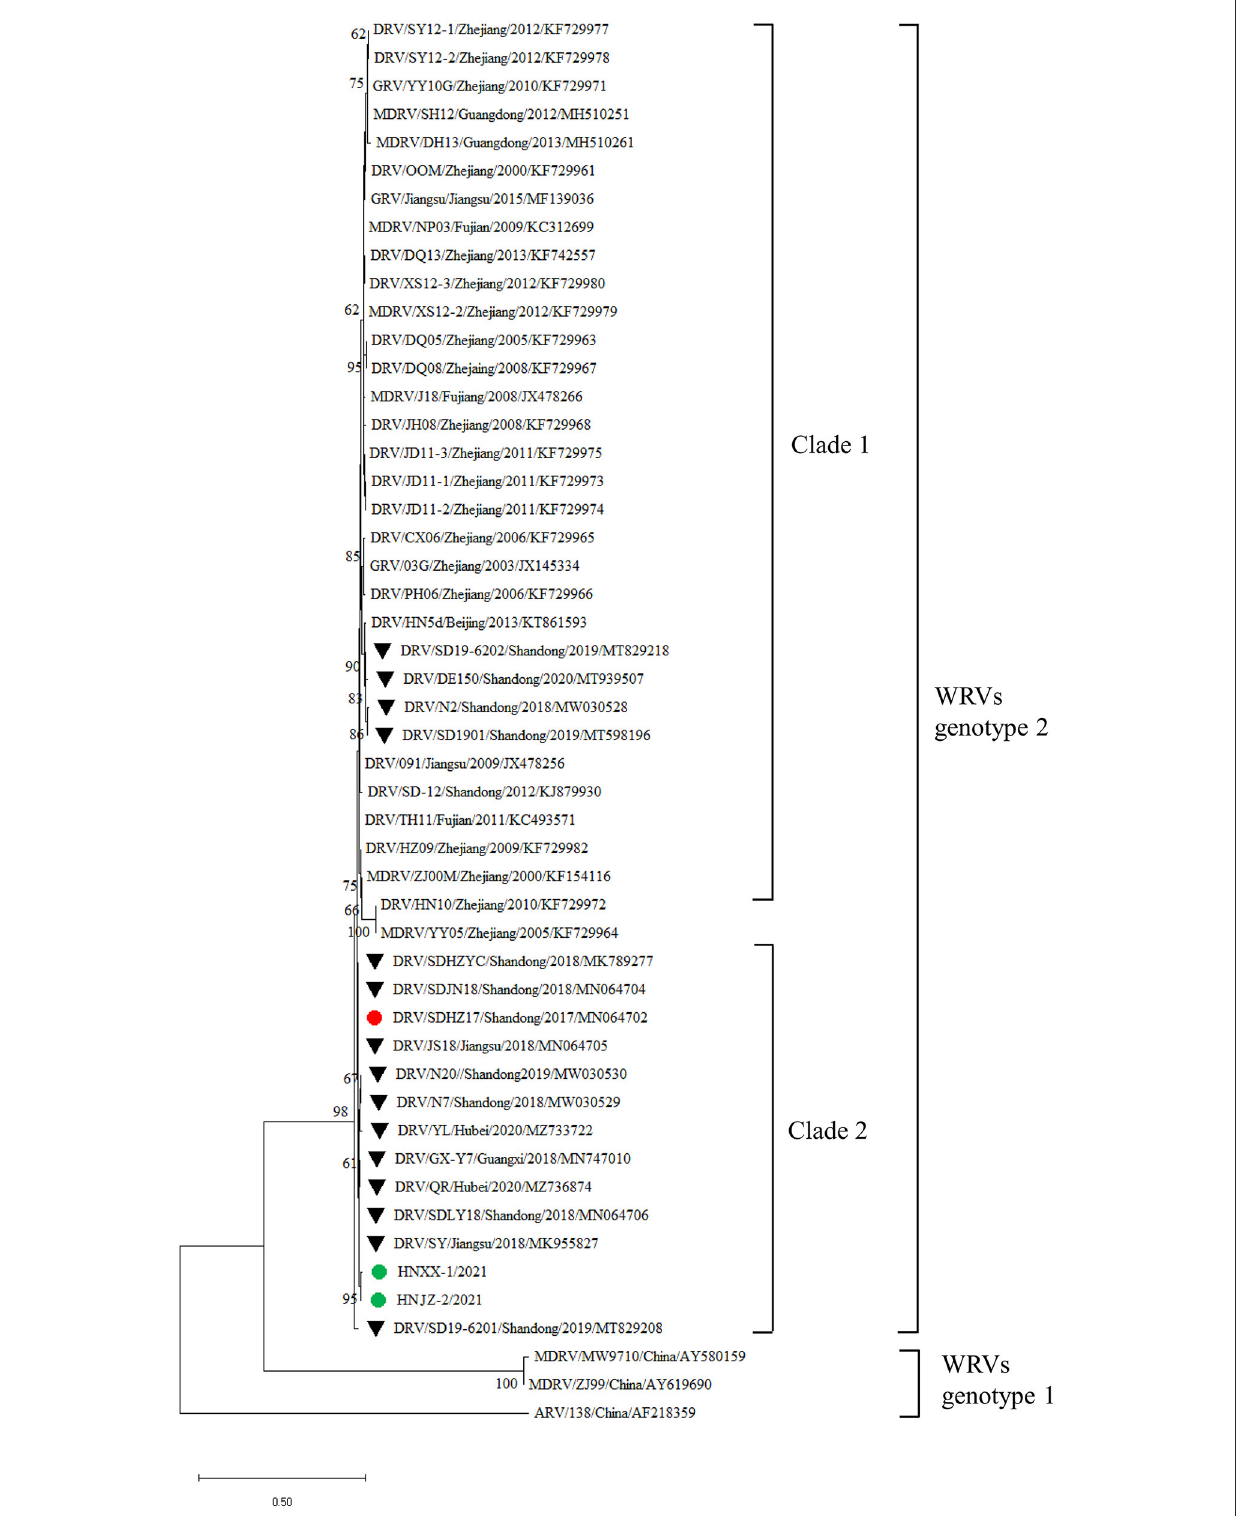
FIGURE4 Phylogenetic tree was constructed based on σ C protein amino acid sequences of DRVs. Numbers at nodes indicated bootstrap percentages obtained after 1,000 replicates. The σ C protein amino acid sequence of a chicken-origin ARV/138/China strain (accession number AF218359) was included as an out-group. The green solid circles indicate the HNXX-1/2021 and HNJZ-2/2021 strains described in this study. The solid triangles indicate NDRV strains emerged after 2017. The province and time in the WRVs name represent the province and time at which the strain was collected,